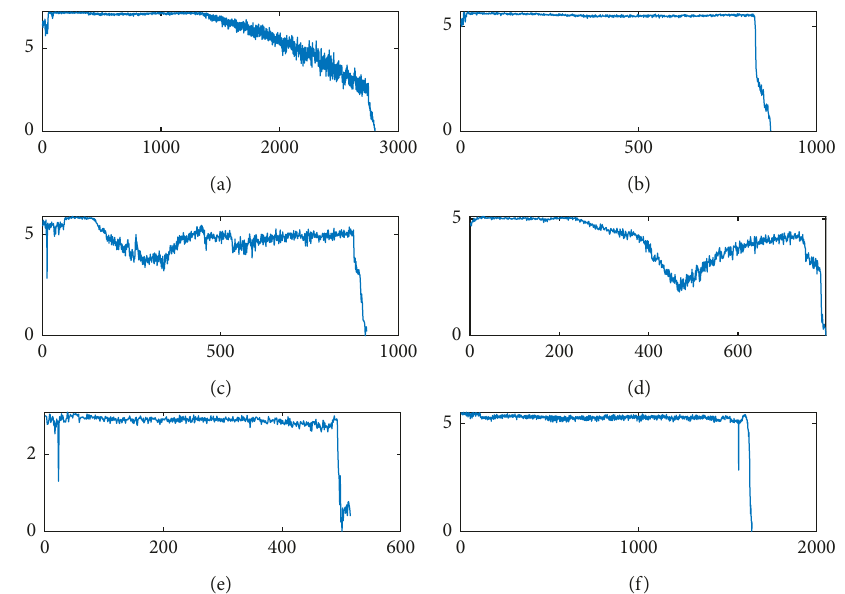
Figure 3: HHE in training sets. (a) Training set 1. (b) Training set 2. (c) Training set 3. (d) Training set 4. (e) Training set 5. (f) Training set 6.